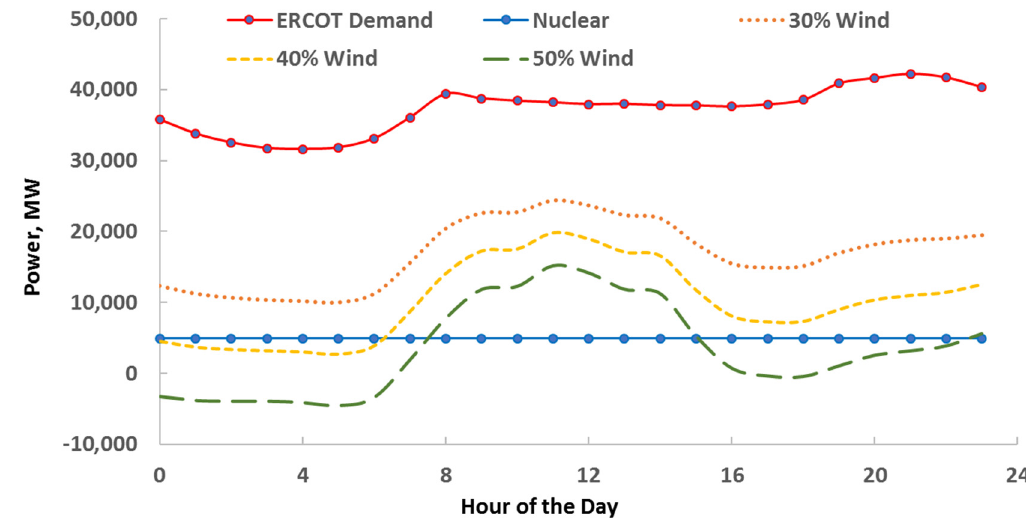
Figure 2. Demand-supply mismatches in the ERCOT system during a day in the spring. Significant power surpluses are created at several periods of high winds during the day.